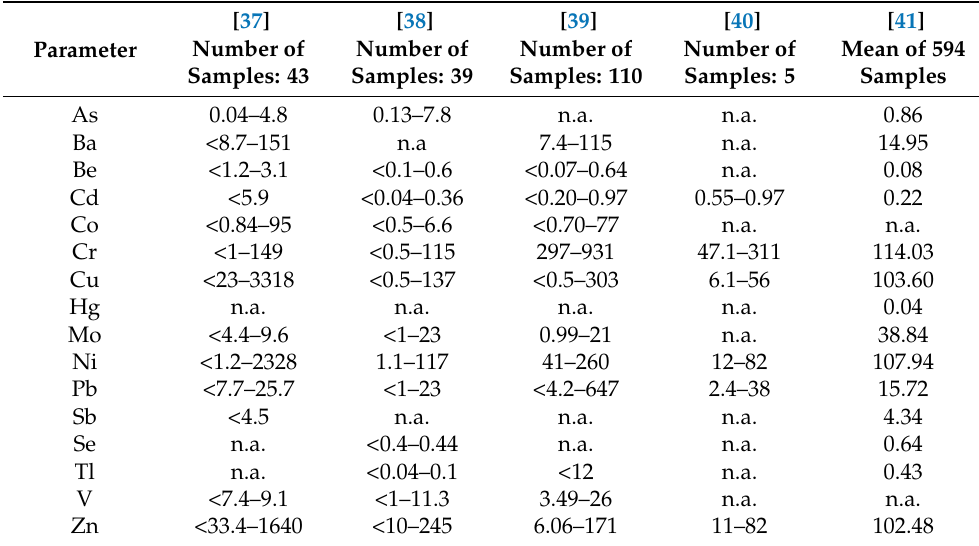
Table 2. Range of concentrations of heavy metals in WFS (mg/kg of